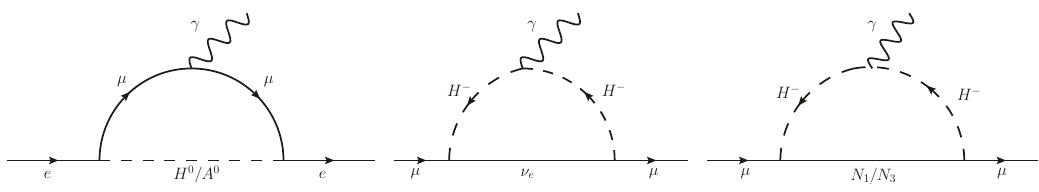
Figure 21 . The diagrams which will contribute to muon and electron magnetic